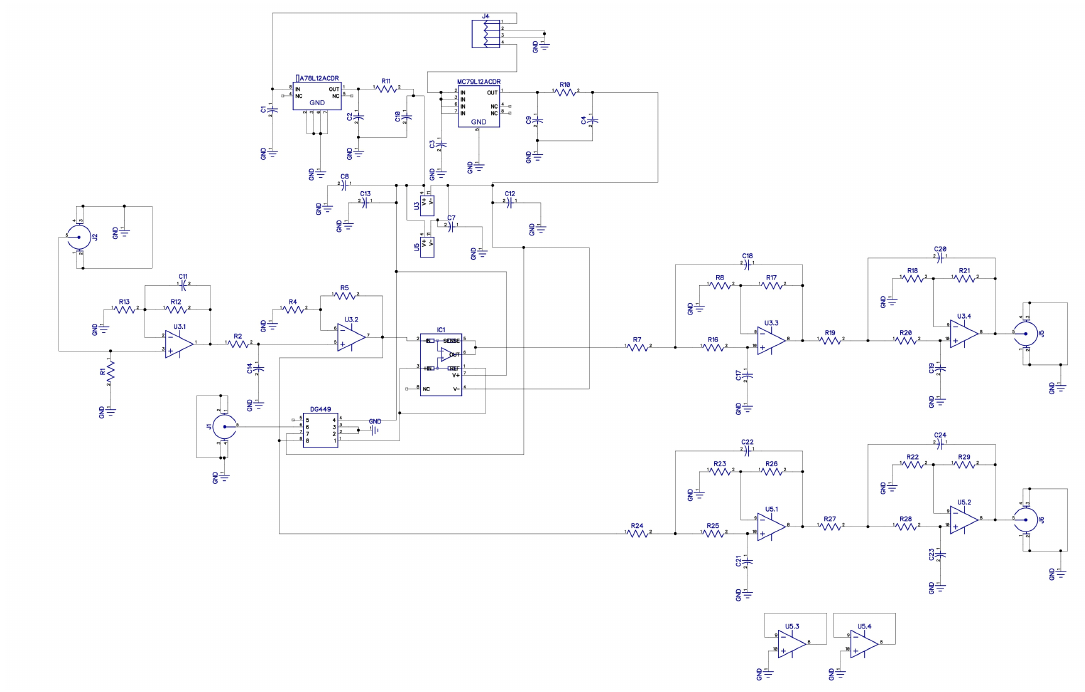
Figure 15. Synchronous demodulator scheme.